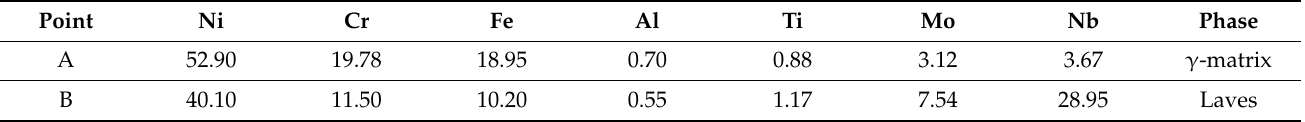
Table 3. Composition analysis and phase identification in Figure 4a measured by EDS point (wt%).